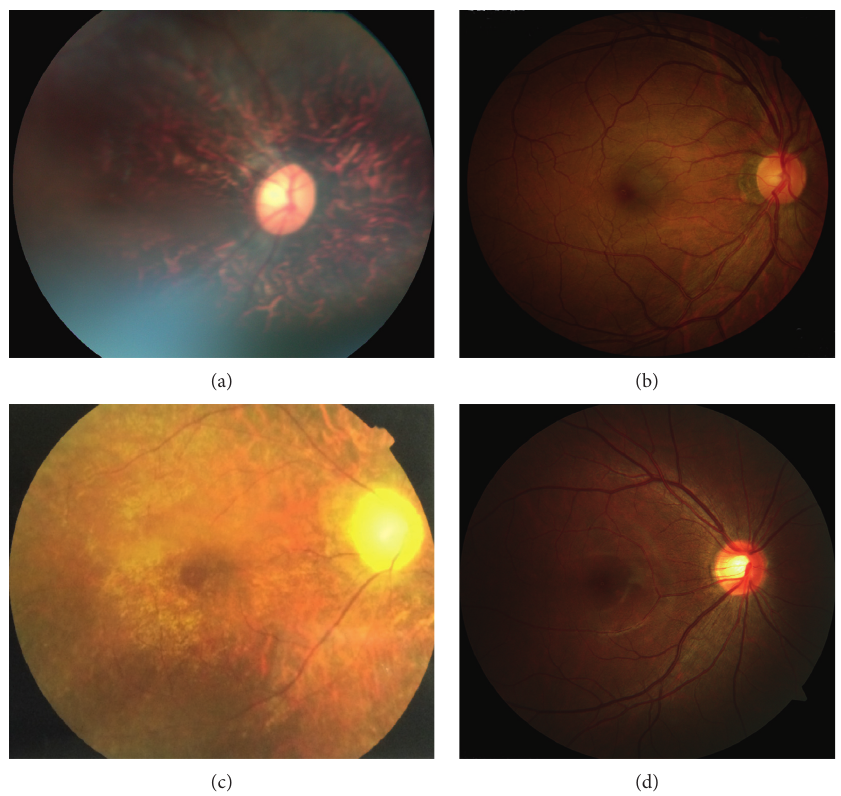
Figure 4: Fundus photos of family A and family B (a). Fundus photo of IV:2 in family A (affected) showing vascular attenuation, retinal pigment epithelium (PRE) disturbance, and disk pallor. (b) Normal fundus photo of III:4 in family A (unaffected). (c) Fundus photo of IV:2 in family B showing vascular attenuation, disc pallor, and retinal pigment epithelium disturbance. (d) Normal fundus photo of IV:1 in family B.